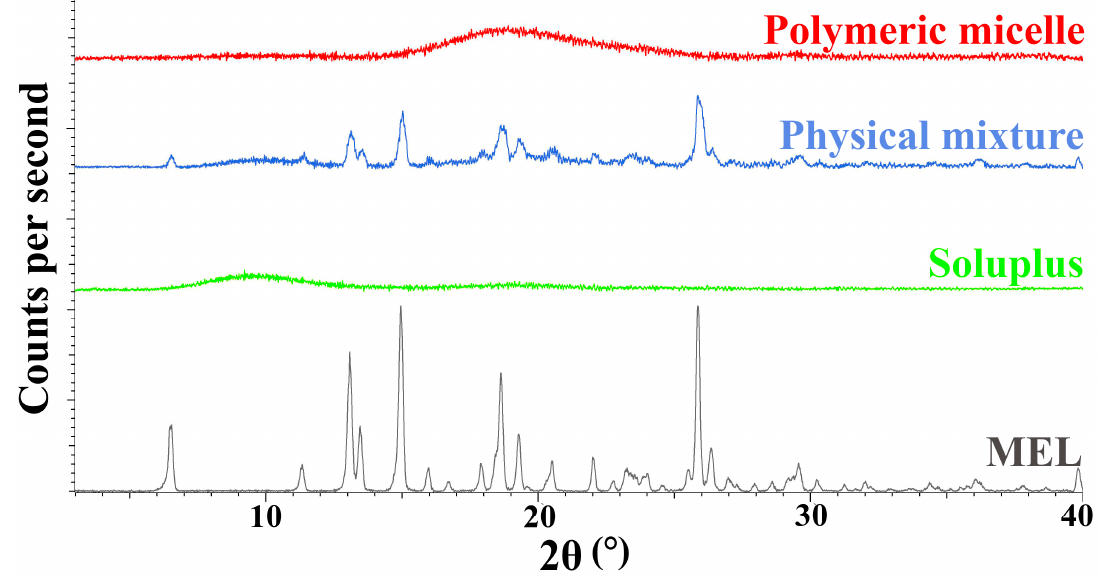
Figure 5. X-ray powder diffractograms of the components and the formulation.